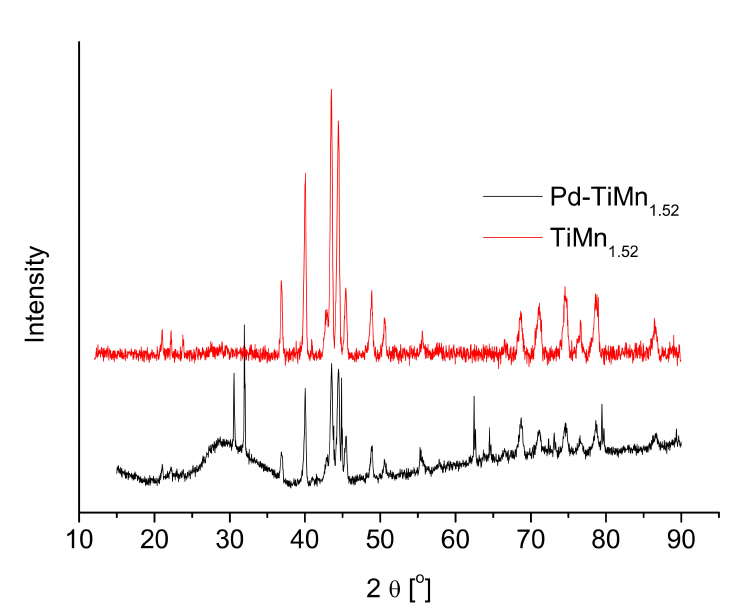
Figure 1. X-ray diffractograms of TiMn 1.52 and Pd–TiMn 1.52